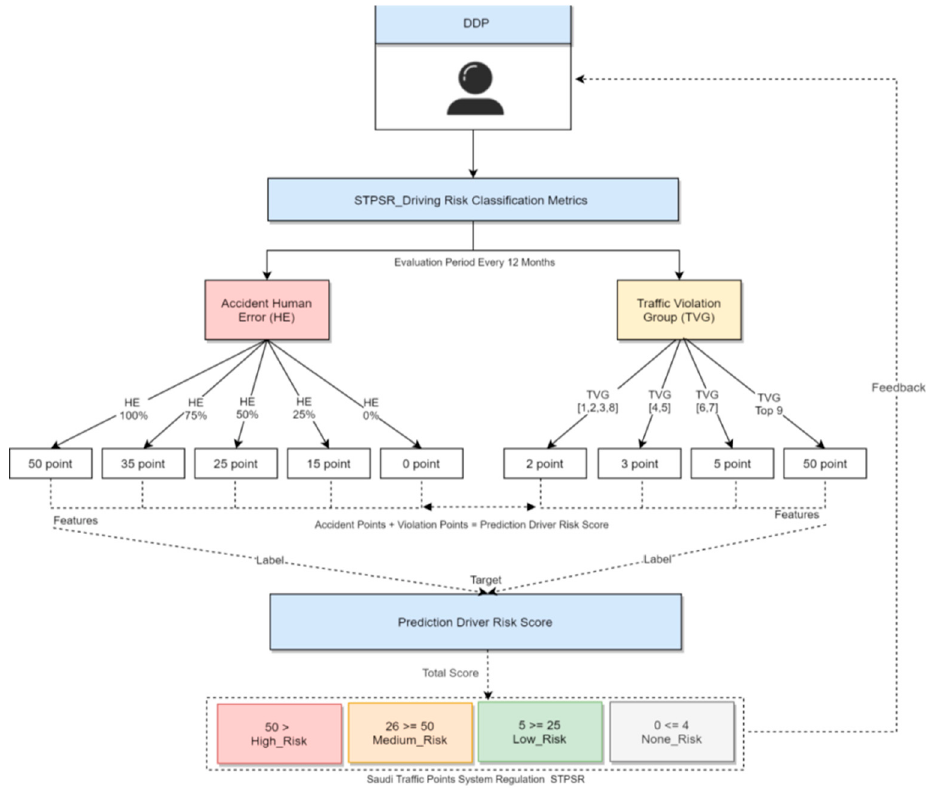
Figure 8. Driver risk classification based on STPSR model risk.